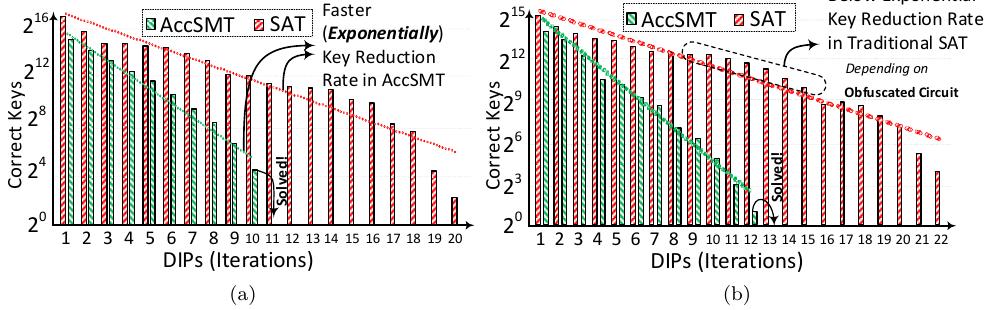
Figure 13: Rate of Reduction in the Number of Potentially Valid Keys (Remaining Keys) in each Iteration of the Original SAT Attack and the AccSMT Attack, when Attacking ISCAS-85 Benchmarks Obfuscated using RLL[RKM10] Obfuscation Scheme: (a) C2670 (b)